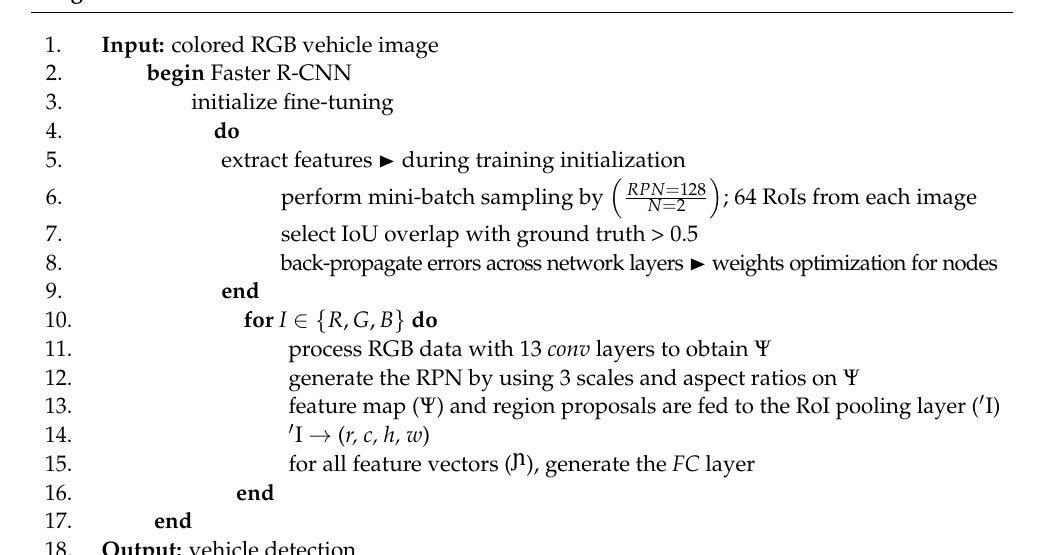
Algorithm 1: Pseudocode of the vehicle detection method.